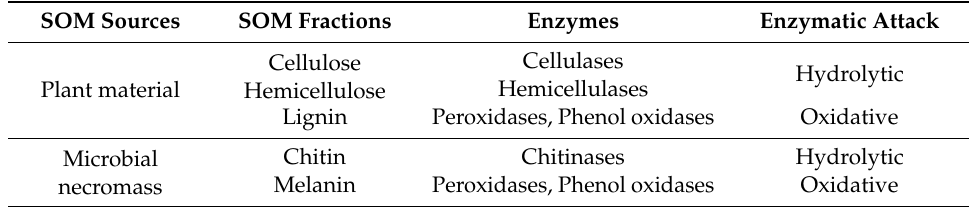
Degradation of soil organic matter (SOM) via extracellular enzymes produced by ectomycorrhizal fungi [29,33]. SOM Sources SOM Fractions Enzymes Enzymatic Attack Cellulases Cellulose Hydrolytic Hemicellulases Plant material Hemicellulose Lignin Peroxidases, Phenol oxidases Oxidative Chitin Chitinases Hydrolytic Microbial Melanin Peroxidases, Phenol oxidases necromass